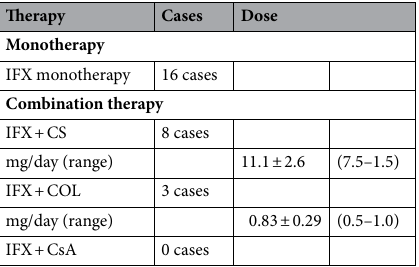
Table 3. Details of IFX monotherapy and combination therapies. IFX: infliximab, CS: corticosteroid, COL: colchicine, CsA: cyclosporin A.